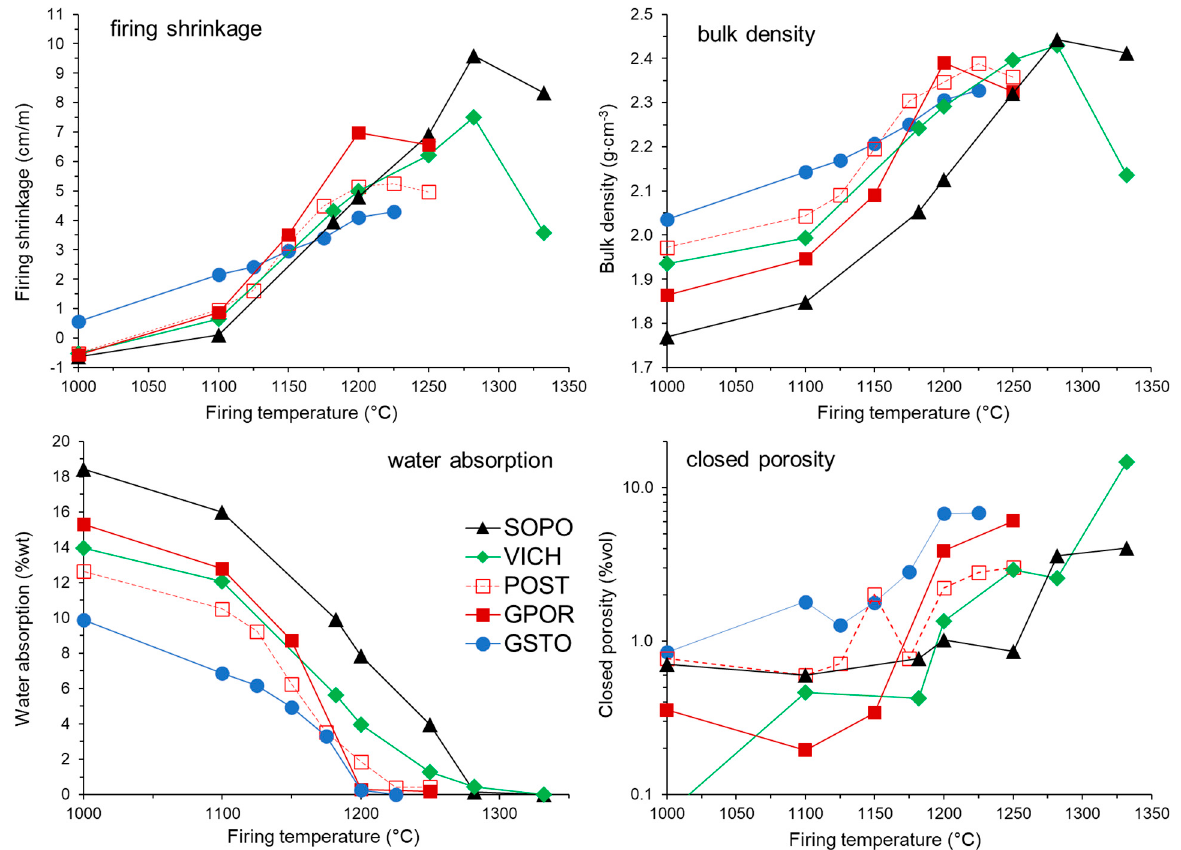
Figure 1. Firing behaviour of the ceramic bodies ( ex-situ experiments).